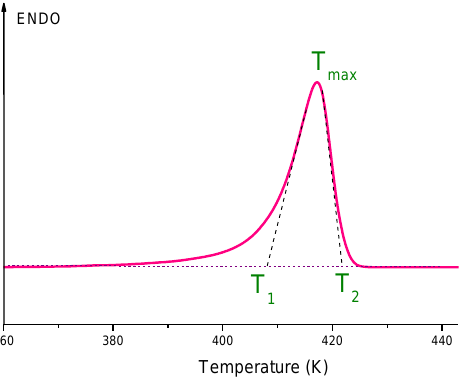
Figure 2. An example of the melting thermogram of the UHMWPE nascent powder.